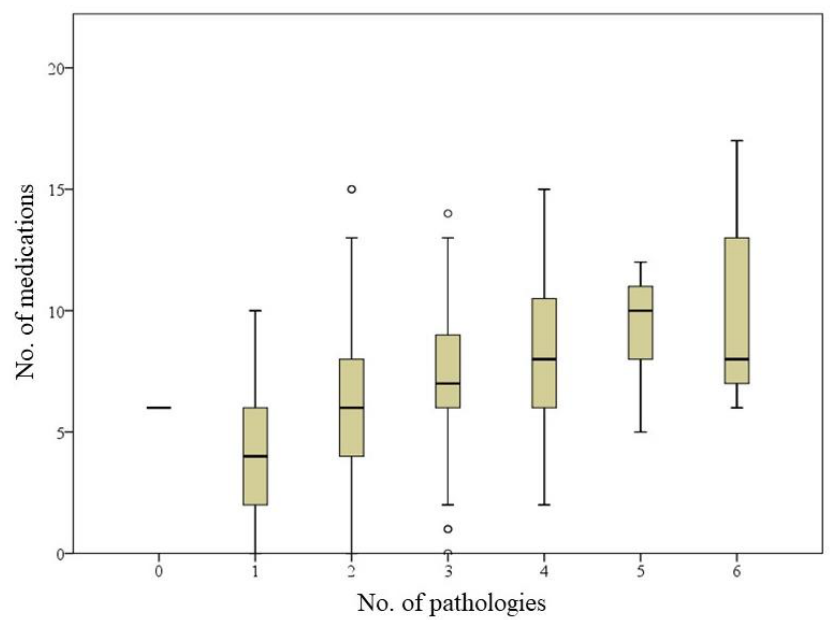
Figure 1. Relationship between polypharmacy and number of pathologies ( 0 : no pathology; 1 : 1–3 pathologies; 2 : 4–6 pathologies; 3 : 7–9 pathologies; 4 : 10–12 pathologies; 5 : 13–15 pathologies; 6 : 16 or more pathologies).